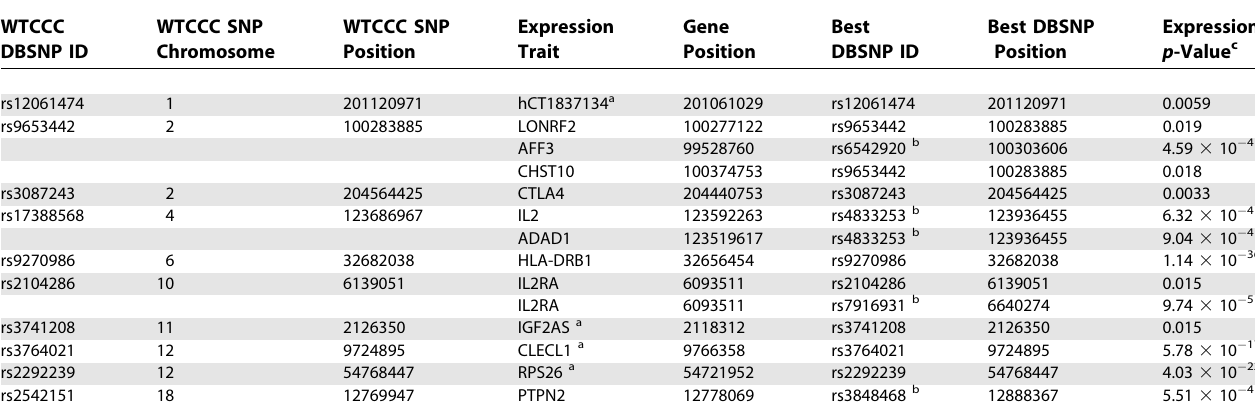
Table 1. Expression Traits Corresponding to Genes Implicated in the T1D WTCCC Study [14,15] or Close to Genes Associated with Either SNPs That Were Associated with T1D in the WTCCC Study or with SNPs Close the T1D-Associated